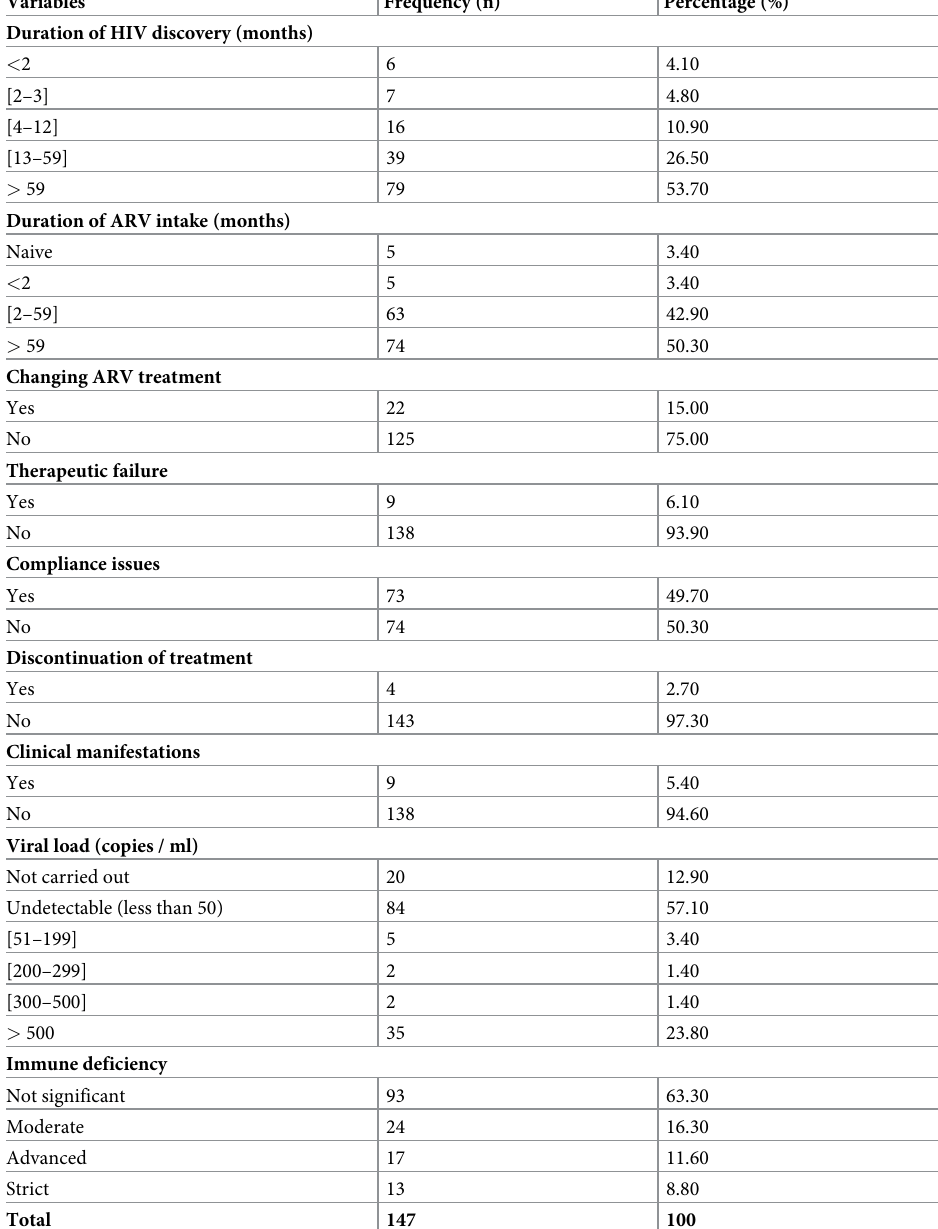
Table 3. Clinical and paraclinical characteristics of pediatric